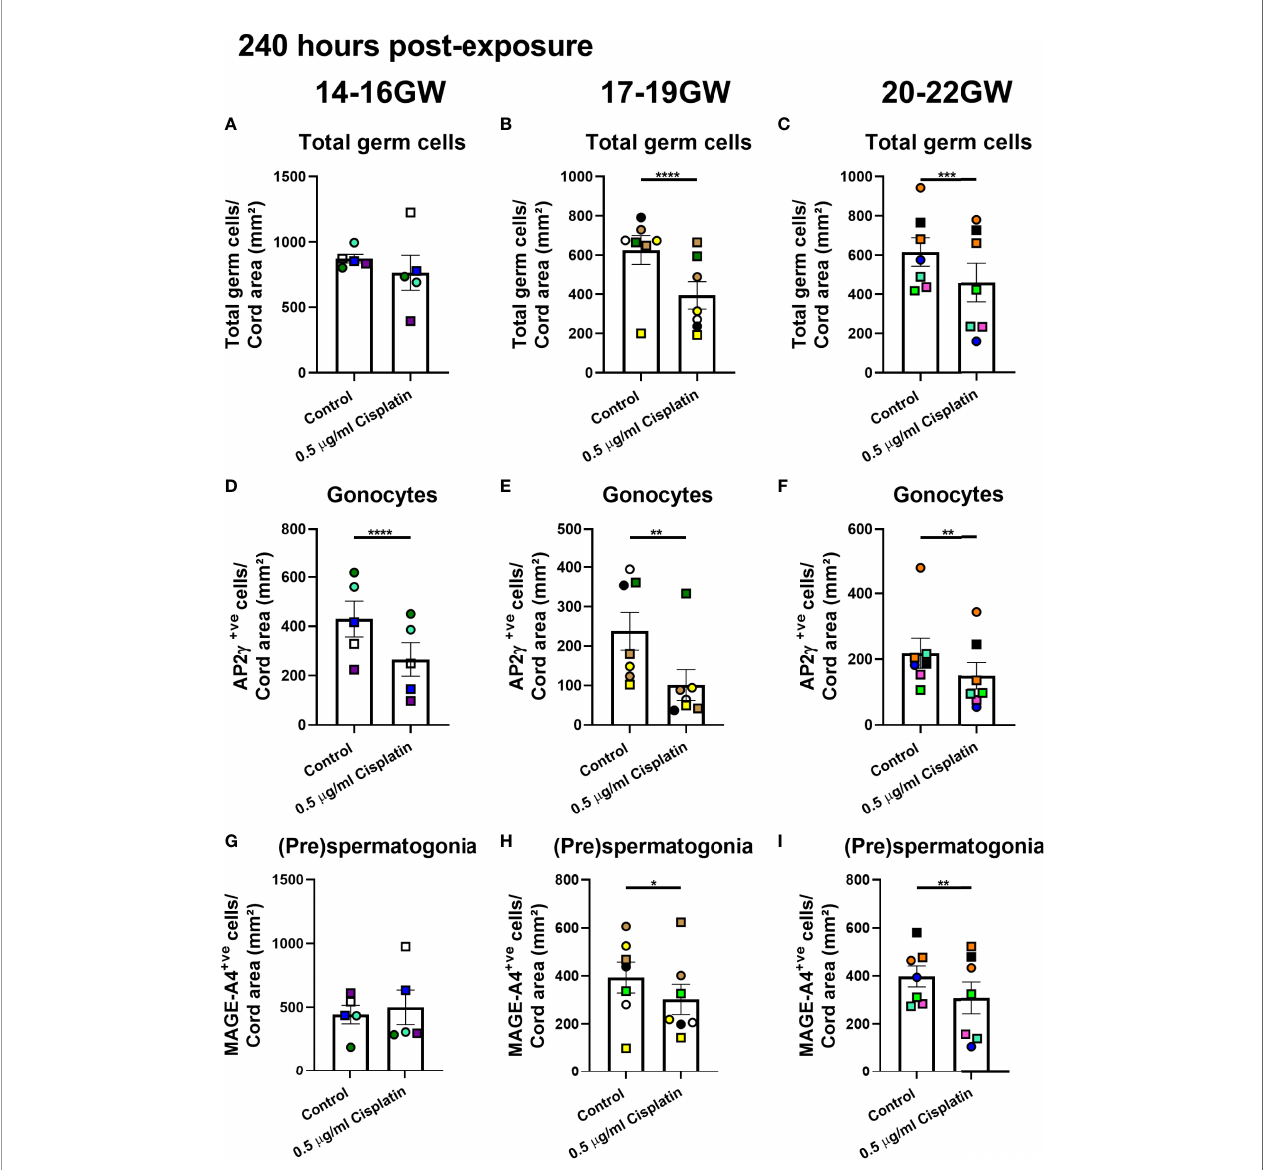
FIGURE 4 | Effects of exposure to cisplatin on germ cell number in human fetal testicular tissues from different gestational age groups at 240 hours post-exposure according to gestational age. Total number of germ cells in early- (A) , mid- (B) and late- (C) second trimester human fetal testis. Gonocyte number in early- (D) , mid- (E) and late- (F) second trimester human fetal testis. (pre)spermatogonial number in early- (G) , mid- (H) and late- (I) second trimester human fetal testis. Data analysed using two-way ANOVA. *p<0.05, **p<0.01, ***p<0.001, ****p<0.0001. Values shown are means ± SEM and each data point represents the mean value for all fragments obtained from an individual fetus